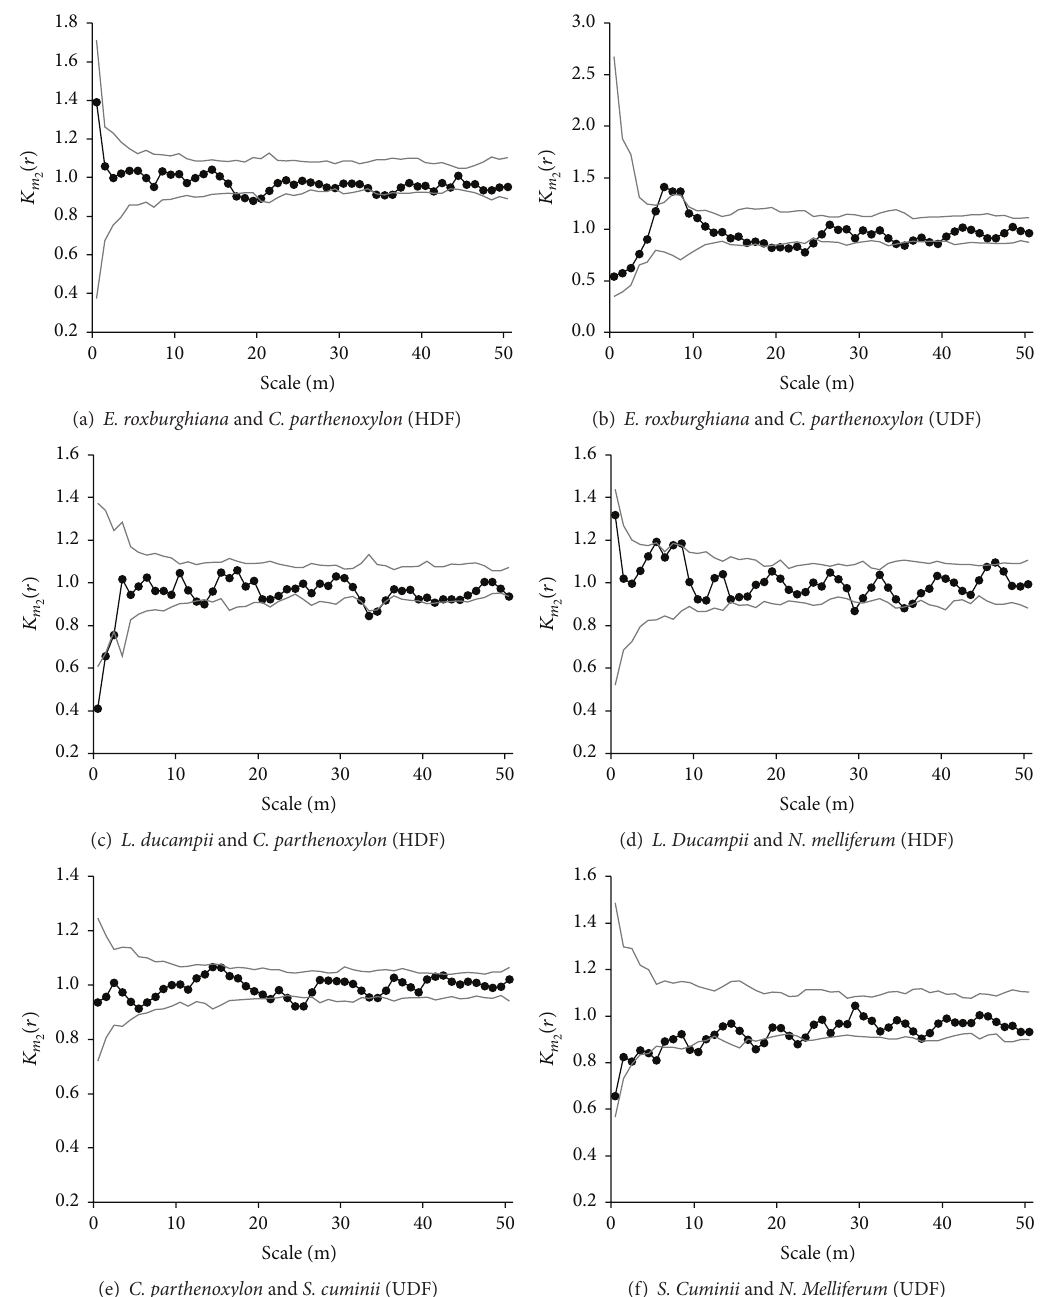
Figure 9: Spatial correlations among the five most abundant tree species are shown by the bivariate mark-correlation functions. The observed patterns (dark line) that lie beyond the confidence envelopes (grey lines) indicate significant departures from the null models of independent